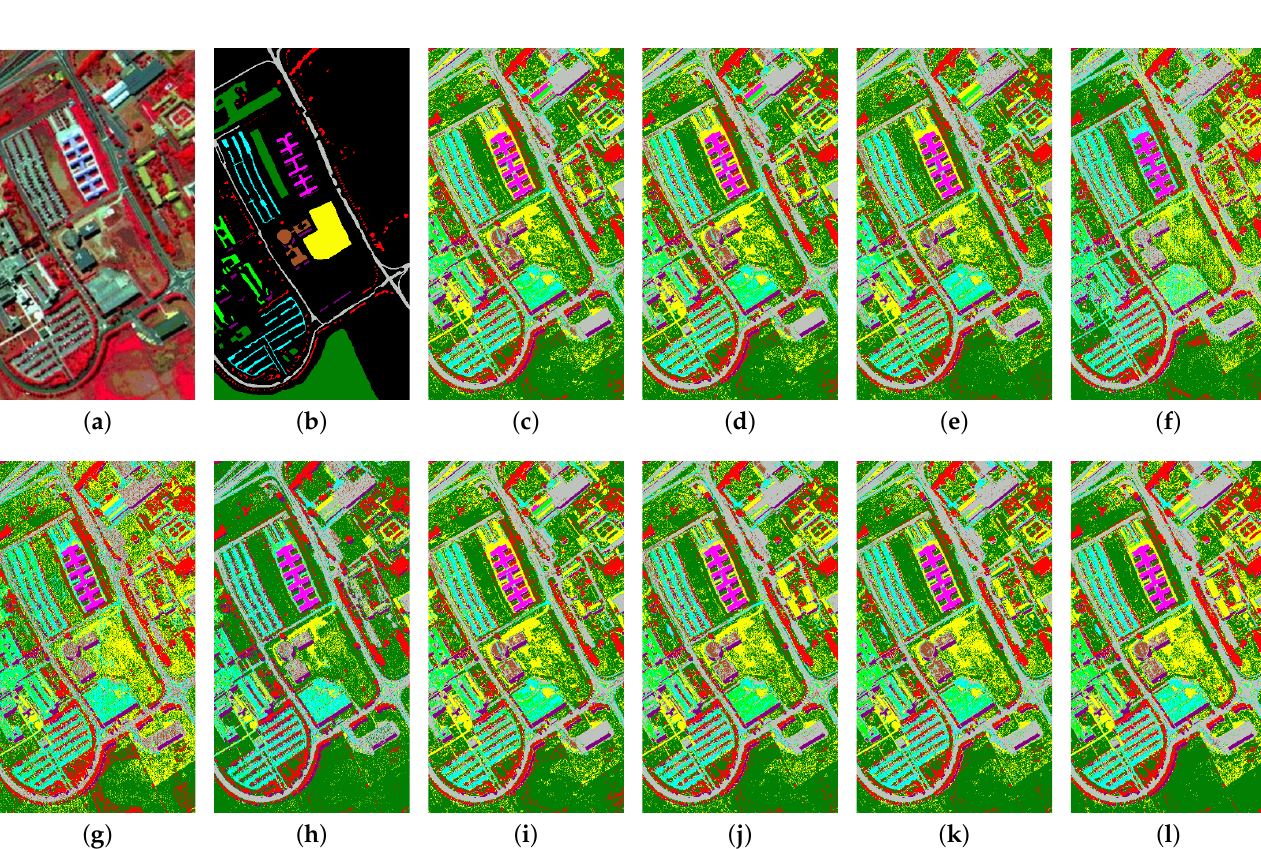
Figure 9. Classification maps for the whole scene on the PaviaU data set. ( a ) False color image; ( b ) ground truth; ( c ) RAW; ( d ) PCA; ( e ) LPP; ( f ) LDA; ( g ) LFDA; ( h ) LGSFA; ( i ) SGDA; ( j ) LGDA; ( k ) CGDA; ( l )